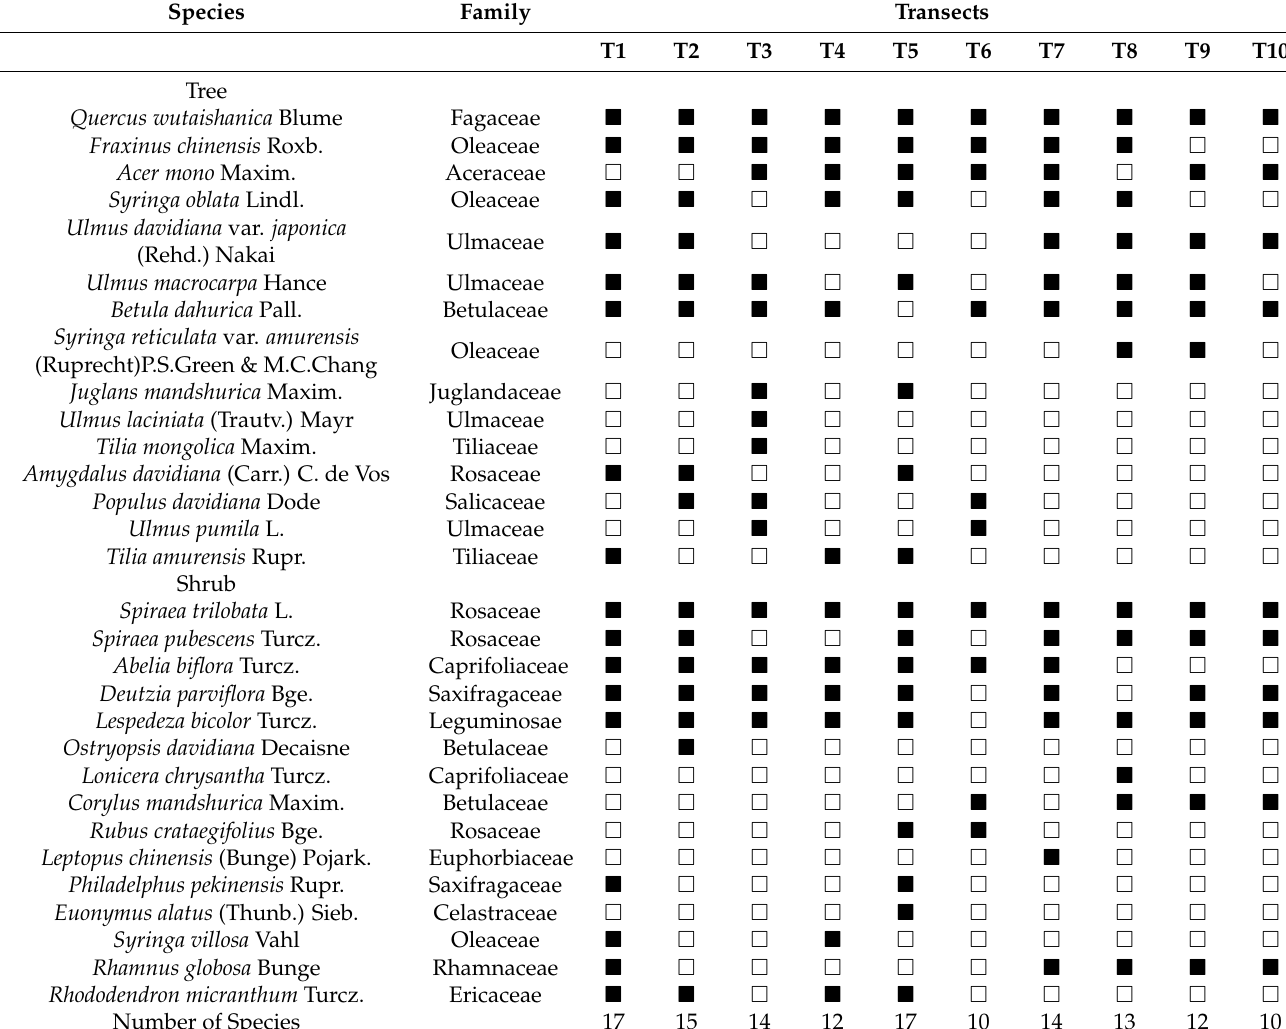
Table A3. The appearance of woody plants in each transect.